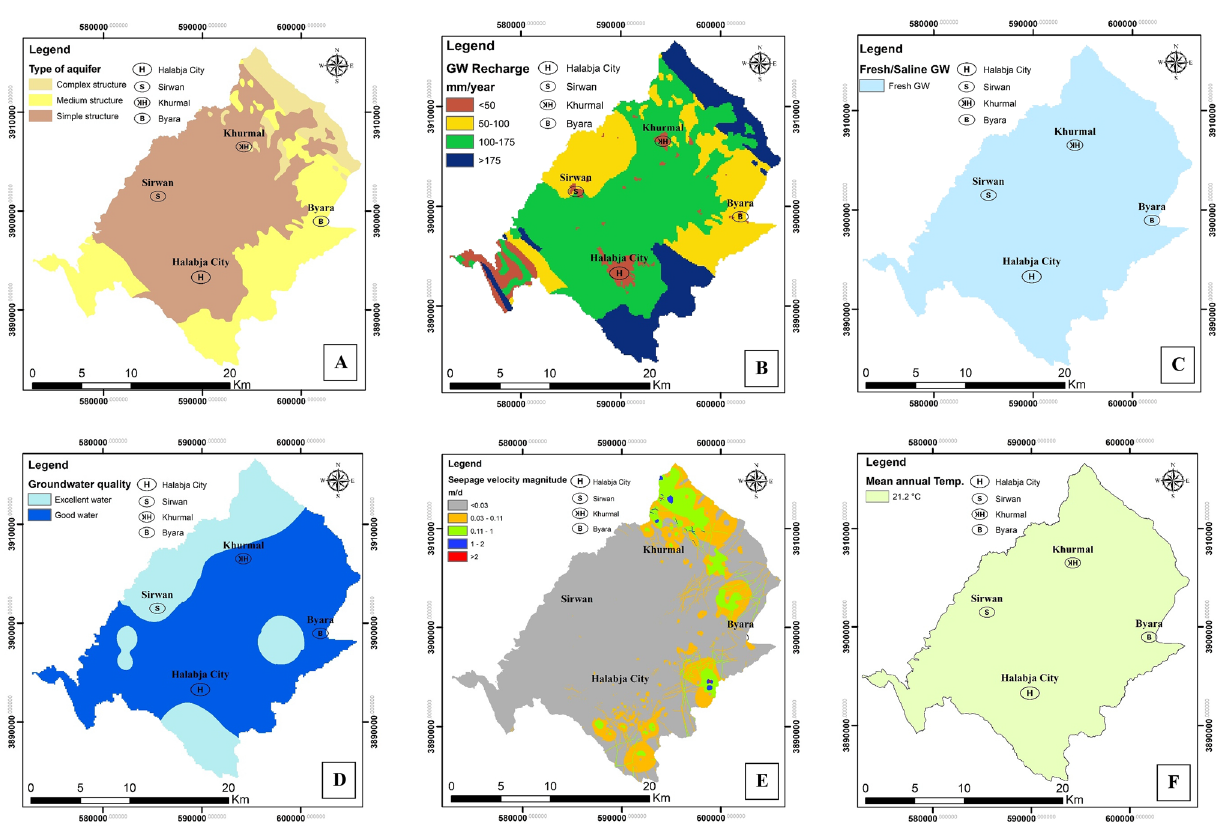
Fig. 3 Input maps for the ATES suitability: A Type of aquifers, B Groundwater recharge, C Fresh/Saline groundwater, D Groundwater quality, E Seepage velocity, and F Mean annual